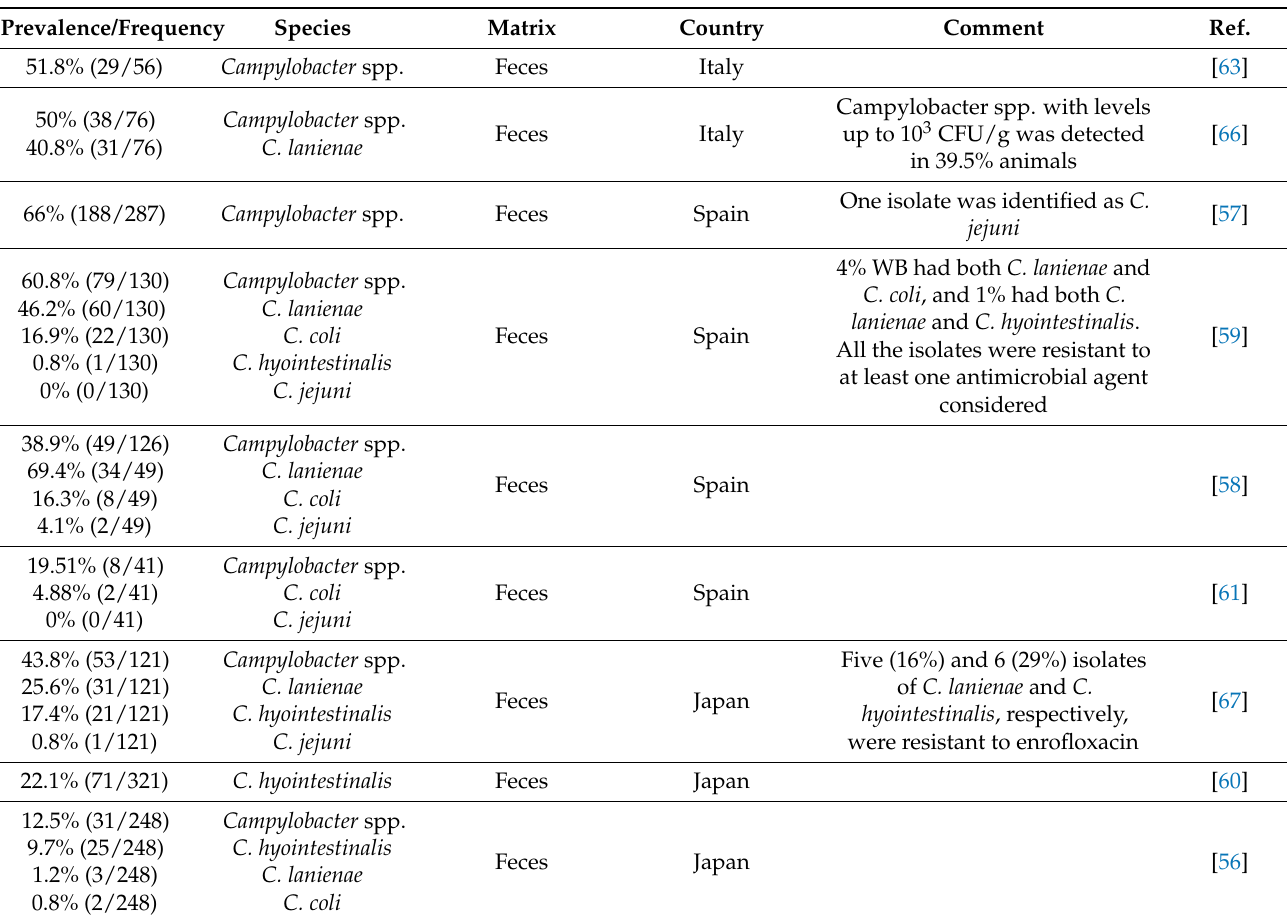
Table 4. Prevalence of Campylobacter spp. in wild boar (2012–2022) feces or on carcasses or meat. Matrix Country